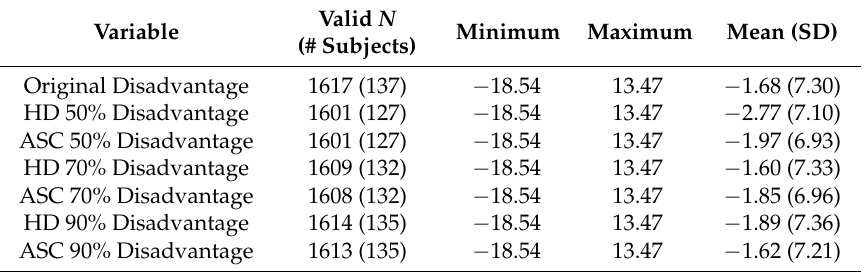
Table 2. Descriptive statistics for observed and imputed neighborhood disadvantage using different imputation methods and for different data sets (HD = hot deck imputation; ASC = activity space centroid imputation; and 50%, 70%, and 90% refer to the percentage of the data retained versus